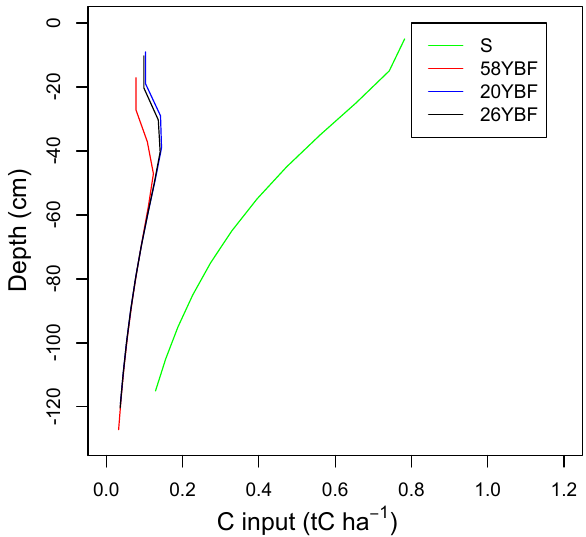
Fig. 7. Fresh organic matter for the four profiles calculated by the model. The steppe, the 20YBF, the 26YBF and the 58YBF are rep- resented by the green line, the blue line, the black line and the red line, respectively. All the models share the same input scheme. We assume that in the models a fraction of the SOM decomposed may be as labile as the FOM and is, therefore, incorporated to the FOM